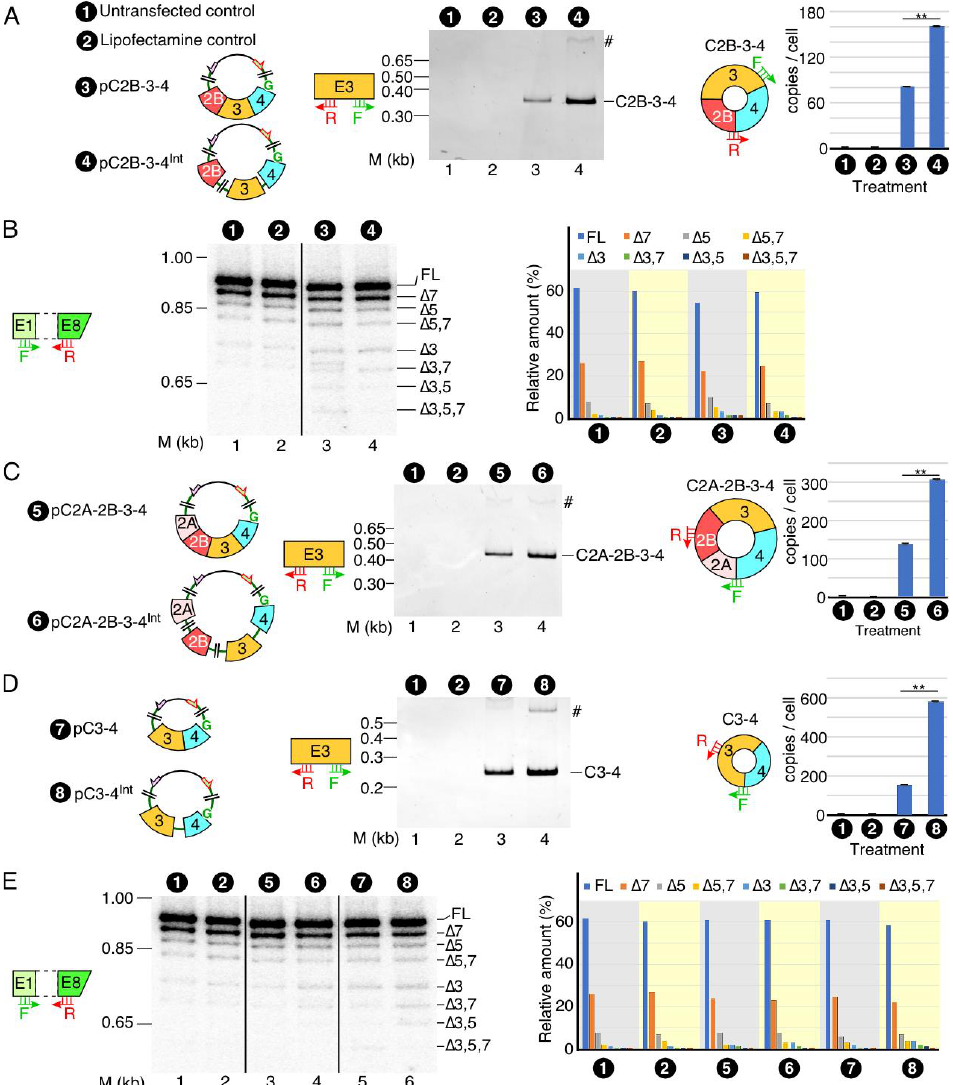
Figure 3. The effect of internal introns on the expression of SMN circRNAs. ( A ) The expression of C2B-3-4. Left panel: diagrammatic representation of plasmid used to overexpress C2B-3-4. Middle panel: a representative gel showing the results of semi-quantitative PCR with divergent primers annealing to exon 3. The type of treatment is specified at the top of the gel. The size marker (M) is indicated on the left side of gel, while the identity of the band is indicated on the right side. A band likely derived from duplicate of indicated circular transcript is marked by “ # ”. Right panel: bar diagram showing the copy number of C2B-3-4 per cell, as determined by qPCR. Annealing positions of primers used are indicated. Error bars represent standard error of the mean. Statistical significance: *, p < 0.05; **, p < 0.01. Abbreviations are the same as in Figure 2. ( B ) Splicing of endogenous linear transcripts of SMN detected by MESDA. Left panel: a representative gel showing the splicing pattern of the endogenous SMN genes in transfected cells, as determined by MESDA. Labeling is the same as in Figure 2E. Right panel: bar diagram showing the relative expression of the individual SMN splice isoforms detected by MESDA as precent of total. Labeling is the same as in Figure 2E. ( C ) The expression of C2A-2B-3-4. Left panel: diagrammatic representation of overexpressed circRNAs, along with their number coding. Middle panel: a representative gel showing the results of semi-quantitative PCR. Labeling is the same as Figure 3A. Right panel: bar diagram showing the copy number of C2A-2B-3-4 per cell, as determined by qPCR. Annealing positions of primers used are indicated. Error bars represent standard error of the mean. Statistical significance: **, p < 0.01. ( D ) The expression of C3-4. Left panel: diagrammatic representation of overexpressed circRNAs, along with their number coding. Middle panel: results of semi-quantitative PCR. Labeling is the same as in Figure 3A. Right panel: bar diagram showing the copy number of C3-4 per cell, as